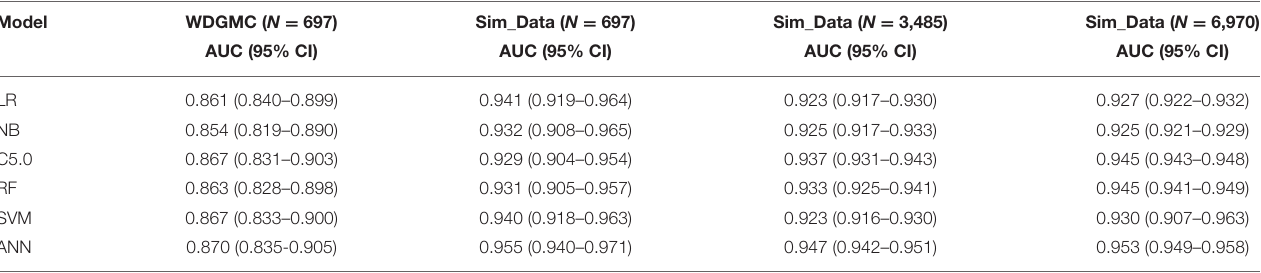
TABLE 4 | AU-ROC performance scores (with confidence interval) examining the consistency of the predictive models from the WDGMC CRC recurrence data and across the three simulated datasets used for model validation. Model